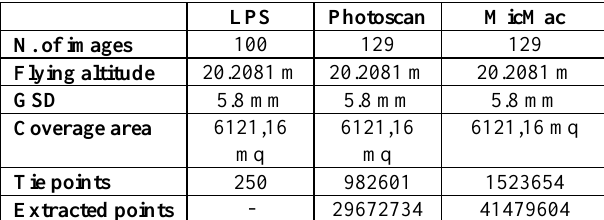
Table 3 - Results of LPS, Photoscan and MicMac process